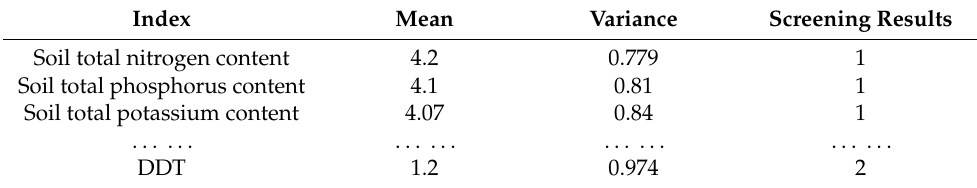
Table 1. Ranking of the importance of evaluation